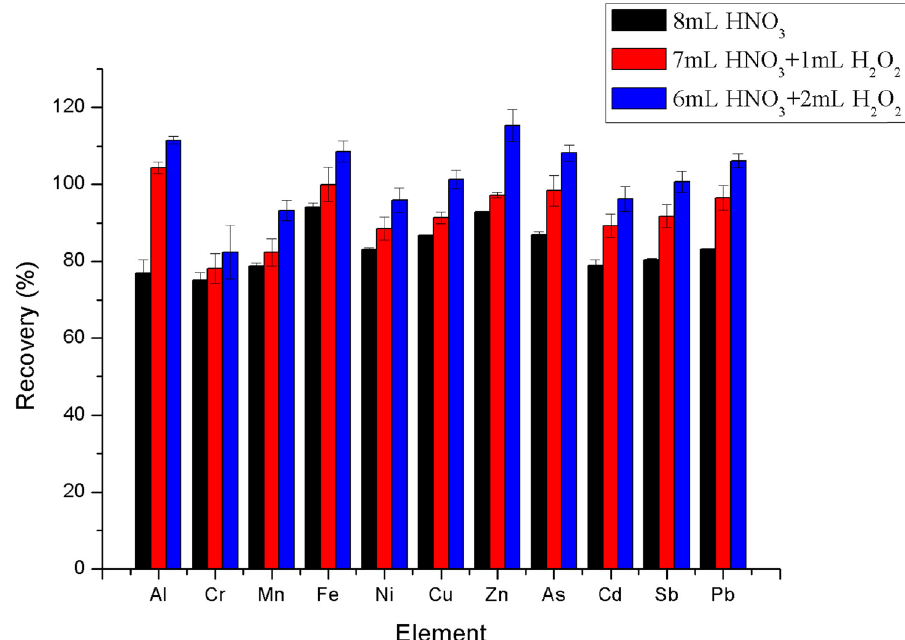
Figure 3: E ff ect of di ff erent levels of H 2 O 2 in digestion solvent on the recovery of each element.